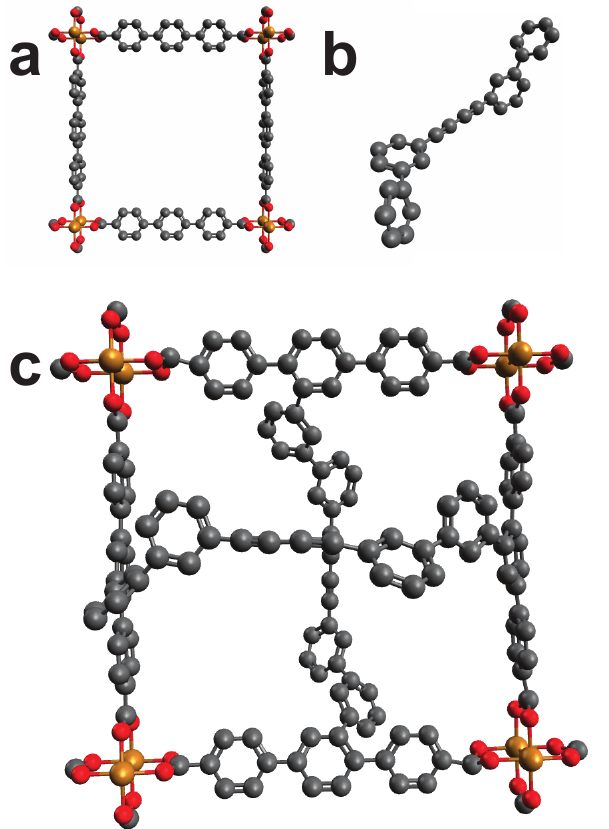
Figure 3. ( a ): First a frame for the MOF was created using AuToGraFS. ( b ): The linker was created again by the principle of handling the reaction partners as already reacted. ( c ): In this case the cross-linker is made up by two separate cross-linkers (that are not connected with each other) with in total four binding points. The cross-linker connects to the frame in a crossed shape and reflects the molecular weaving. Color code: Black (C), Red (O), Gold (Cu). Hydrogens omitted for